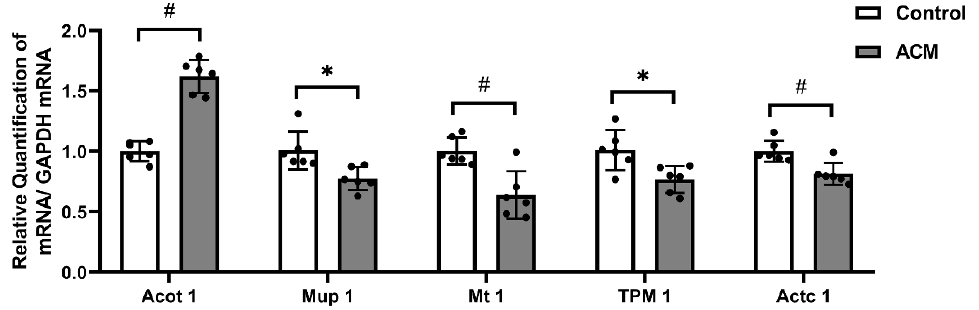
Figure 6. Real-time qPCR results of Acot 1, Mup 1, Mt 1, TPM 1, and Actc 1 mRNA (# p < 0.01; * p < 0.05 ) .